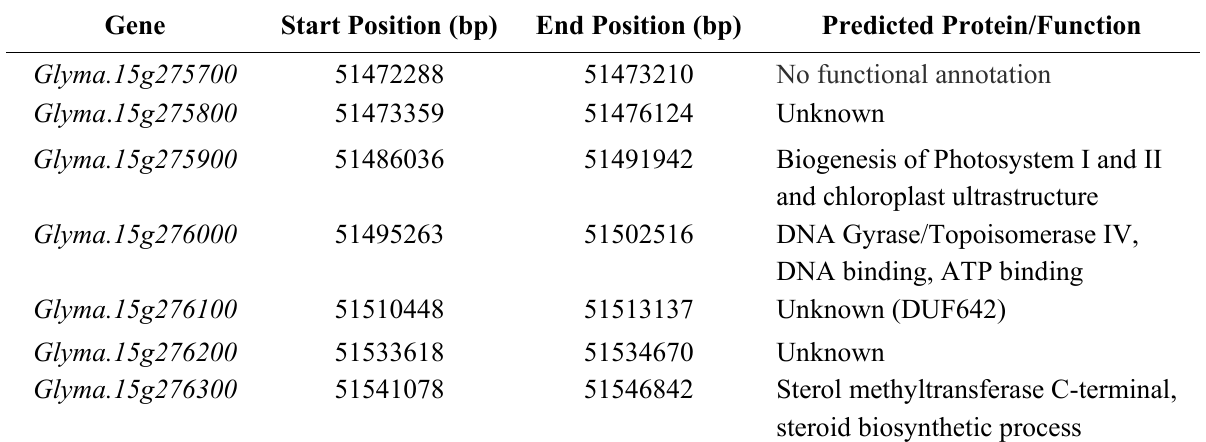
Table 2. Predicted genes present in the genomic region containing the lethal-yellow gene; names and predicted functions of the putative proteins encoded by 14 genes that are flanked by BARCSOYSSR_15_1591 and BARCSOYSSR_15_1597 on Gm15 (MLG E) are